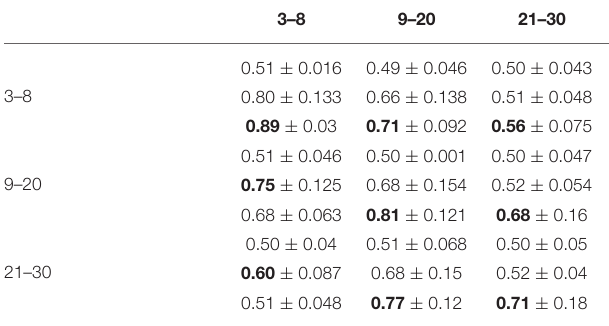
Columns correspond to training datasets, rows to testing datasets. Each block corresponds to one train-set/test-set combination. In each block, the results are given from top to bottom for Deep Set, RDS and MPGNN. Diagonal blocks correspond to matching train set/test set combinations. All reported results are averages and standard deviations over 10 different runs. Rows and columns are annotated with the n obj range. Bold values indicate highest average